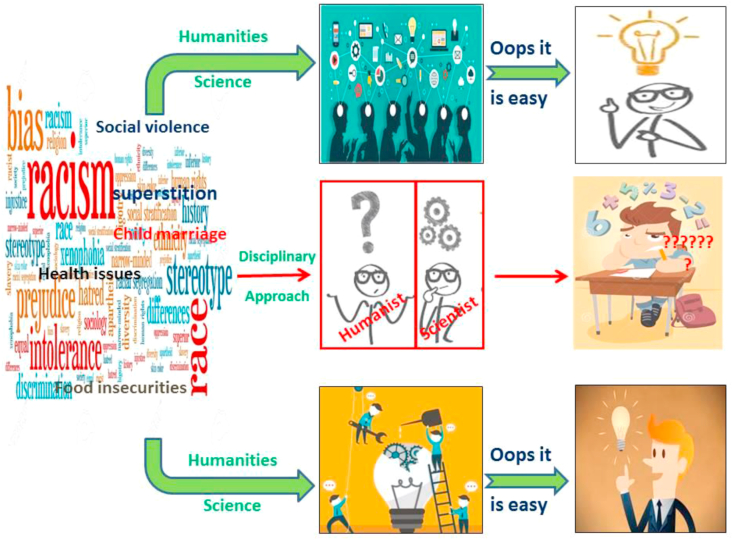
Self-explanatory figure displaying the need of pace in interdisciplinary work to solve regional, national and international issues.